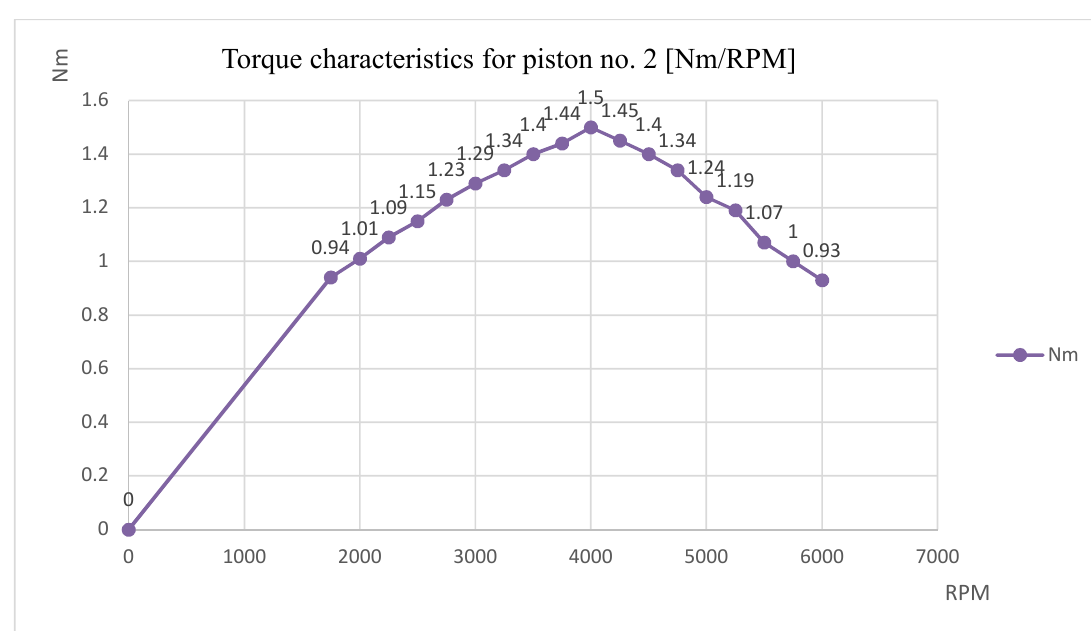
Figure 21. Engine torque characteristics for piston no. 2.